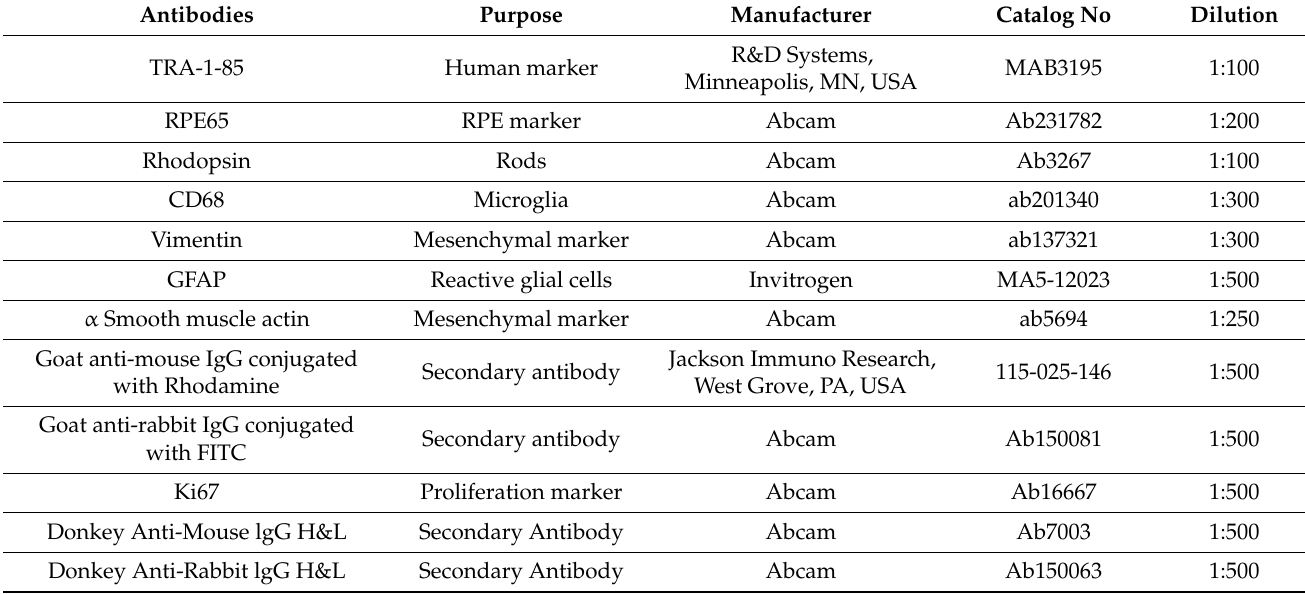
Table 1. List of antibodies used for